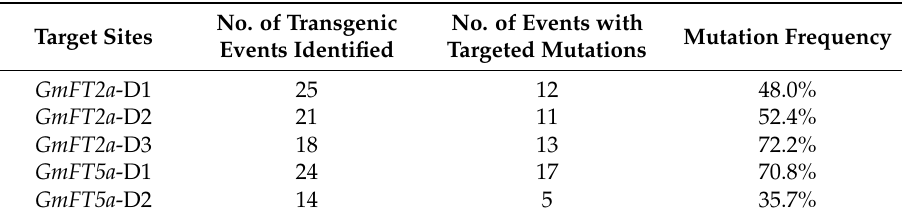
Table 1. Frequencies of mutations at target sites among T0 transgenic plants transformed by constructs targeting single